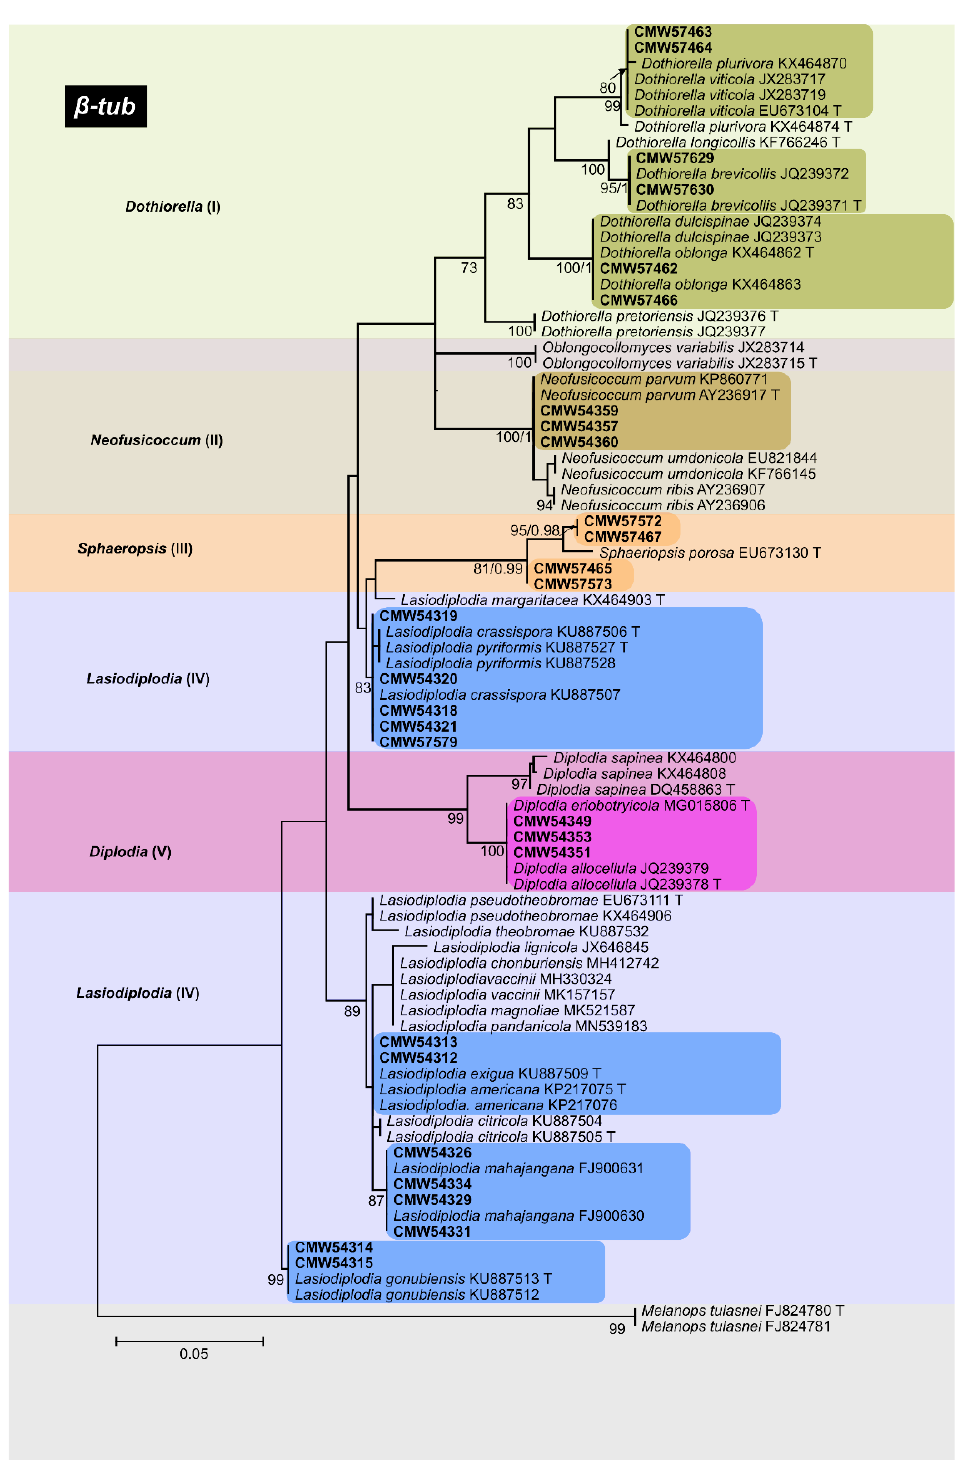
Figure 4. Phylogenetic tree obtained from ML and BI analyses of the β -tub dataset. Bootstrap values (>70%) and PP values (>0.95) appear at the nodes. Isolates in bold were obtained during this study. The tree was rooted to isolates of Melanops tulasnei.